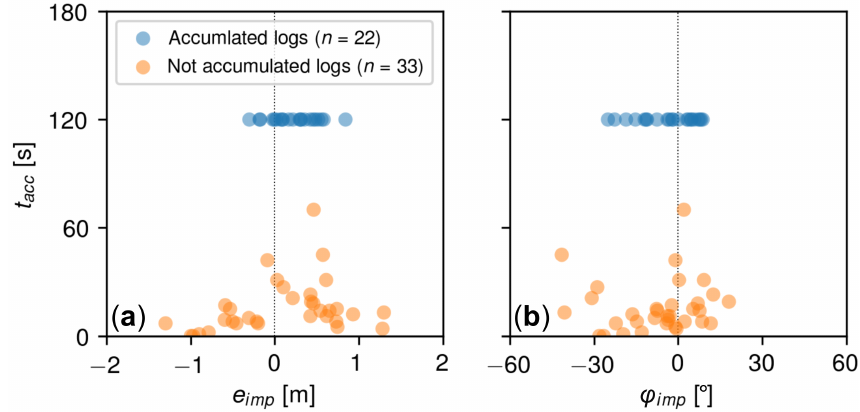
Figure 8. Accumulation time t acc versus ( a ) impact eccentricity e imp and ( b ) impact yaw ϕ imp for accumulated and not accumulated logs.